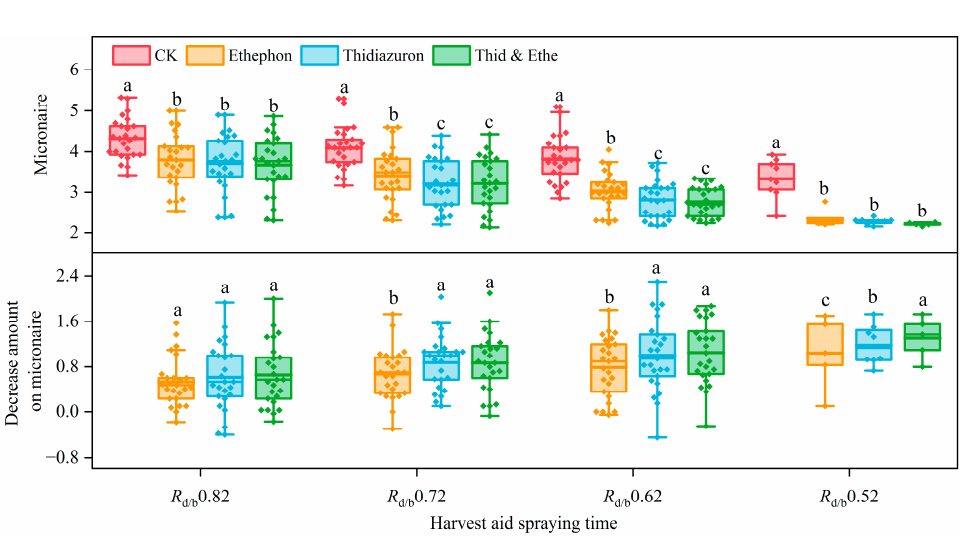
Figure 8. Effects of harvest aid spraying time on fiber micronaire. The thick solid line in the figure indicates the average value. The different letters indicate significant differences between harvest aid treatments at the same spraying time ( p < 0.05). When spraying occurred at R d/b 0.52, the number of samples was 9, and the number of other samples was 25.